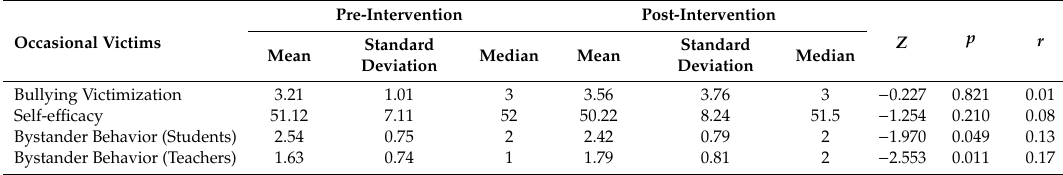
Bullying victimization, self-e ffi cacy and the perceived bystanders’ behavior of the occasional